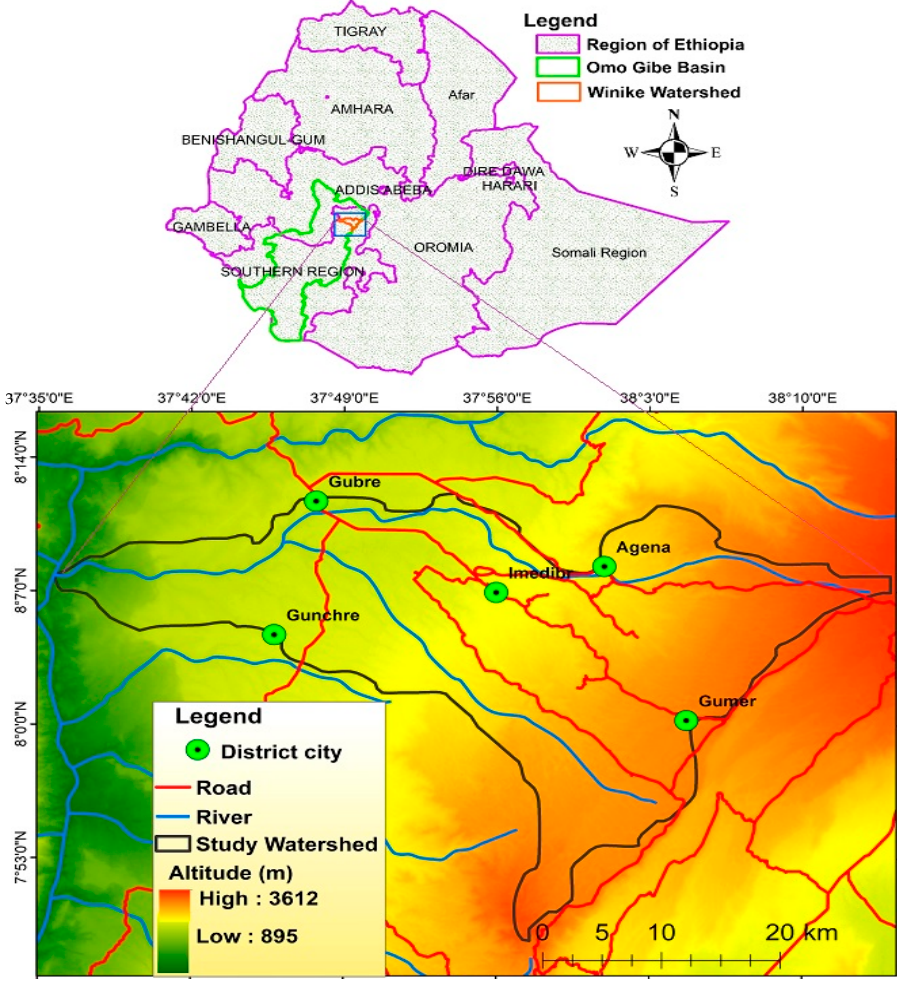
Figure 1. Spatial location of the investigated watershed. Remote Sens. 2020 , 12 , x FOR PEER REVIEW